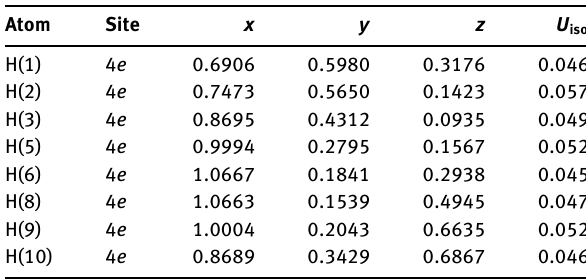
Table 2: Atomic coordinates and isotropic displacement